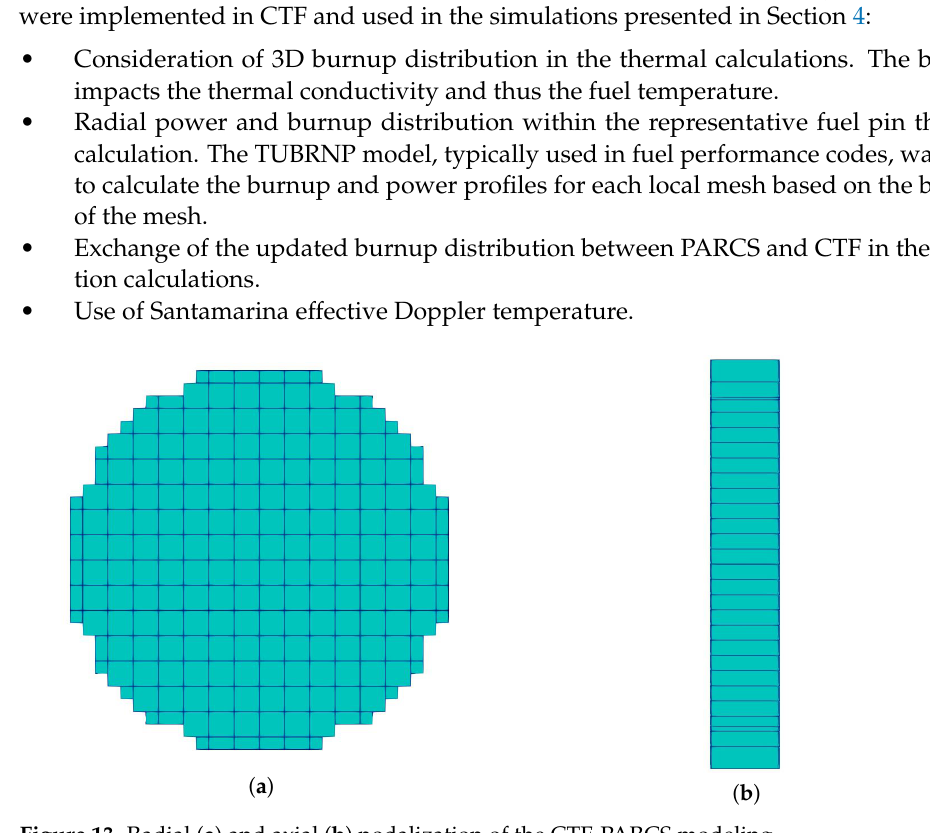
Figure 13. Radial ( a ) and axial ( b ) nodalization of the CTF-PARCS